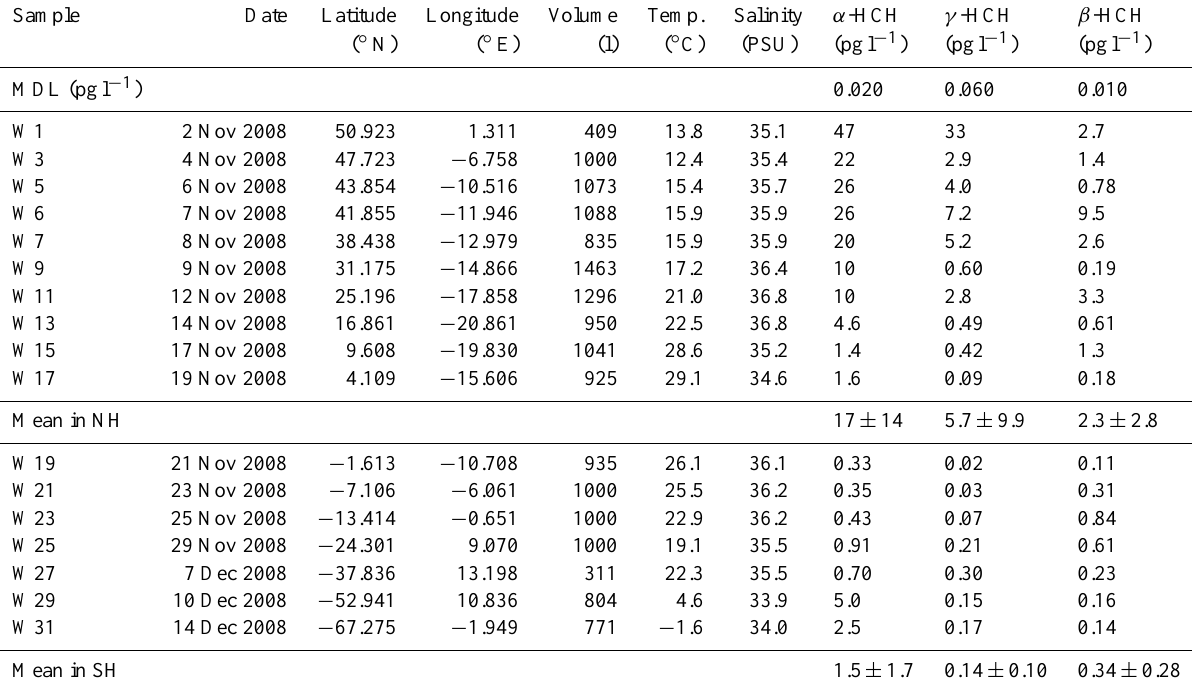
Table 2. Individual concentrations of HCHs in surface seawater (pgl − 1 ) in the Atlantic and the Southern Ocean.